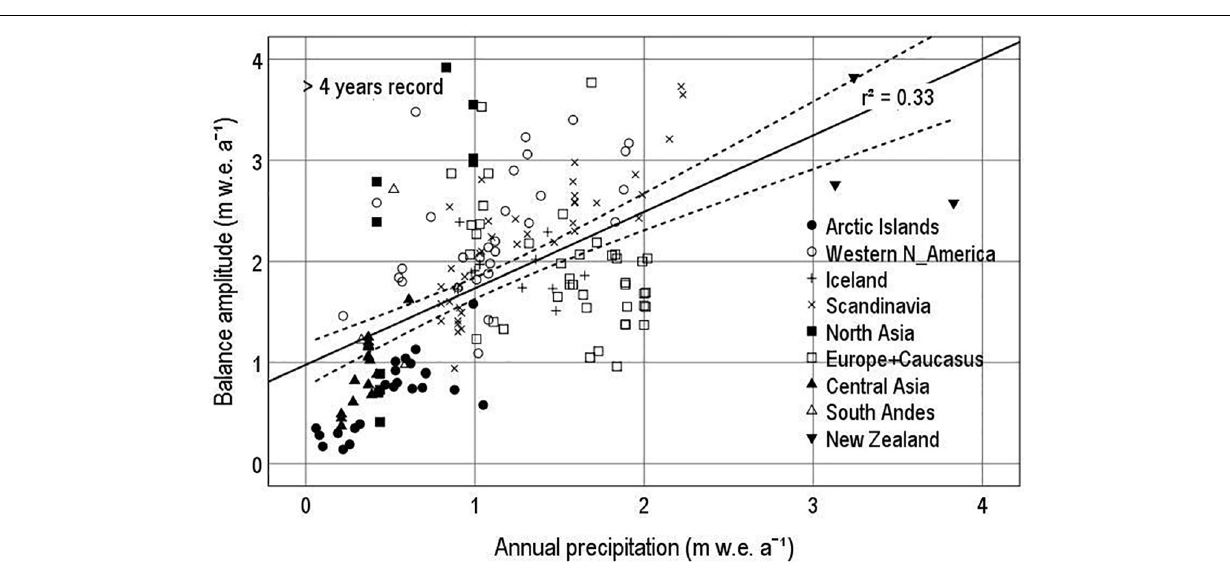
( Figure 7 ). For eight out of nine regions, average balance amplitude is much higher than regional average annual altitude. There is only one group of glaciers (New